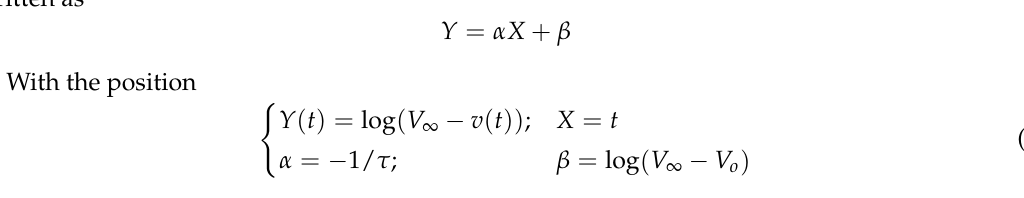
Figure 8. Input power vs. the current density supplied to the PEM EL.